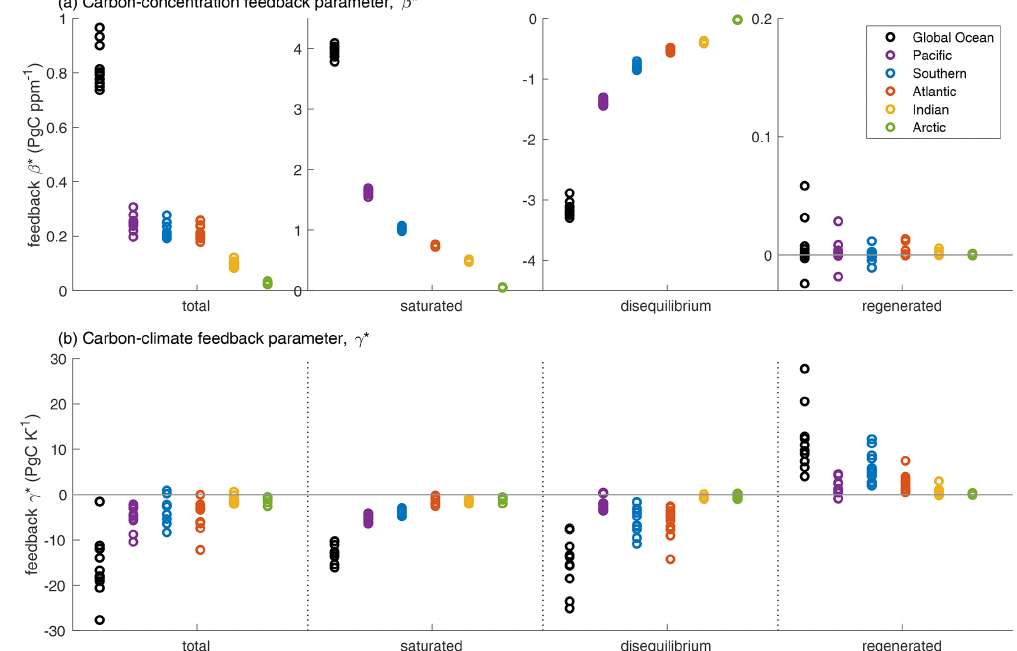
Figure 5. Carbon cycle feedback parameters based on carbon storage, along with the contribution from the saturated, disequilibrium and regenerated carbon pools, for the global ocean and the different ocean basins in 11 CMIP6 Earth system models (Table 1): (a) carbon– concentration feedback parameter, β ∗ (PgCppm − 1 ), and (b) carbon–climate feedback parameter, γ ∗ (PgCK − 1 ). The estimates are based on the fully coupled simulation (COU) and the biogeochemically coupled simulation (BGC) under the 1%yr − 1 increasing CO 2 experiment. Diagnostics are from years 121 to 140 (the 20 years up to quadrupling of atmospheric CO 2 ). For the inter-model mean and standard deviation of these estimates, see Supplement Table S1. Note that for the global ocean, β ∗ and γ ∗ are equivalent to β and γ